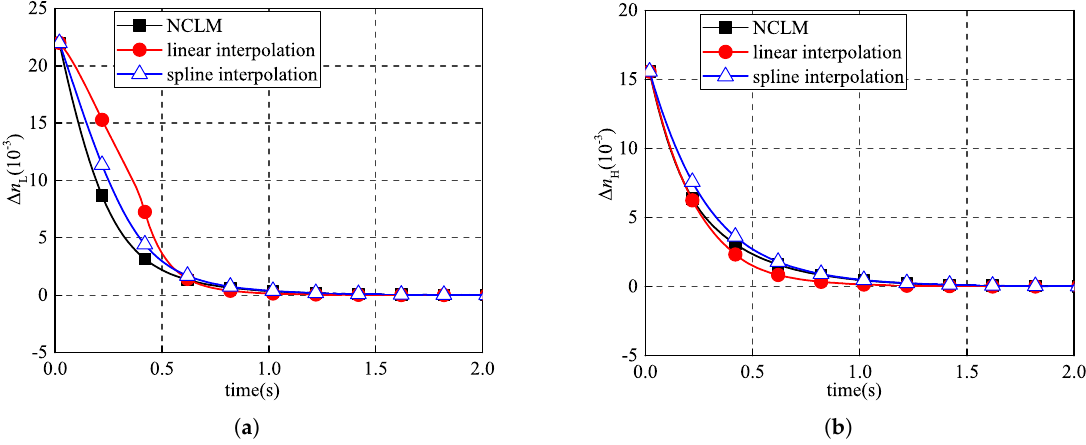
Figure 7. The comparison of state response of linear systems: ( a ) Response of n L ; ( b ) response of n H